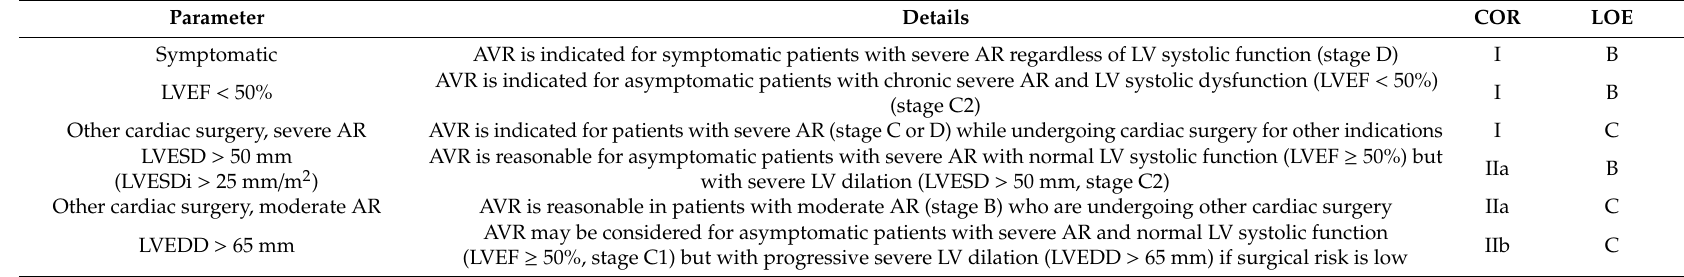
Table 1. Summary of AHA / ACC 2014 guideline recommendations for AR intervention.